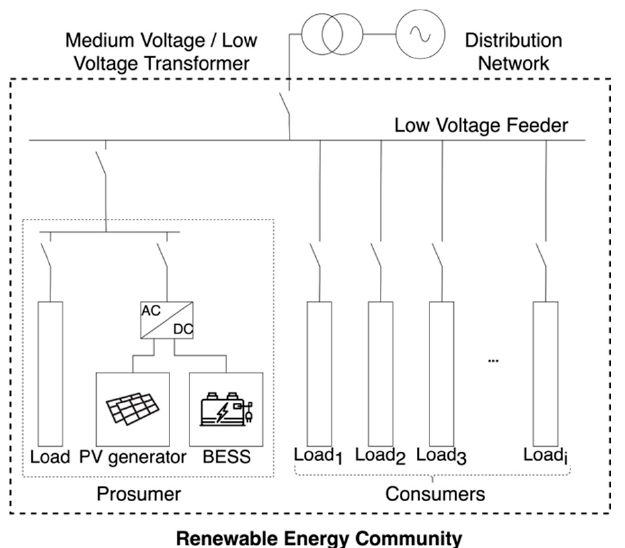
Figure 1. General architecture of a Renewable Energy Community.